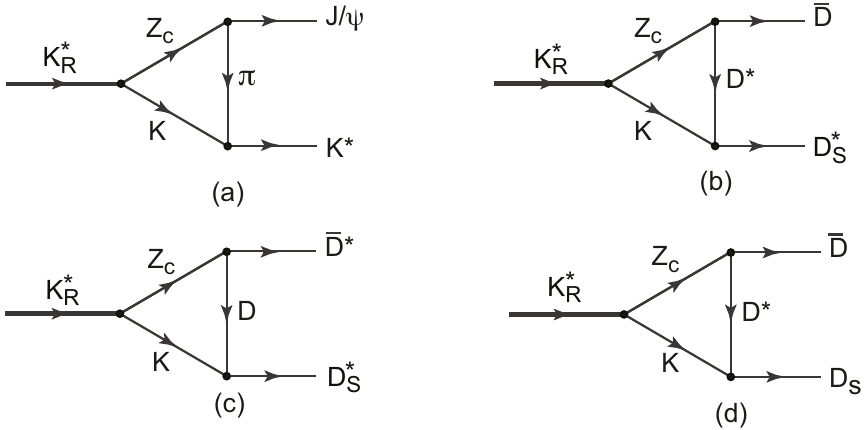
Figure 2 . Main two-body decay channels for the K (cid:3) of ref.